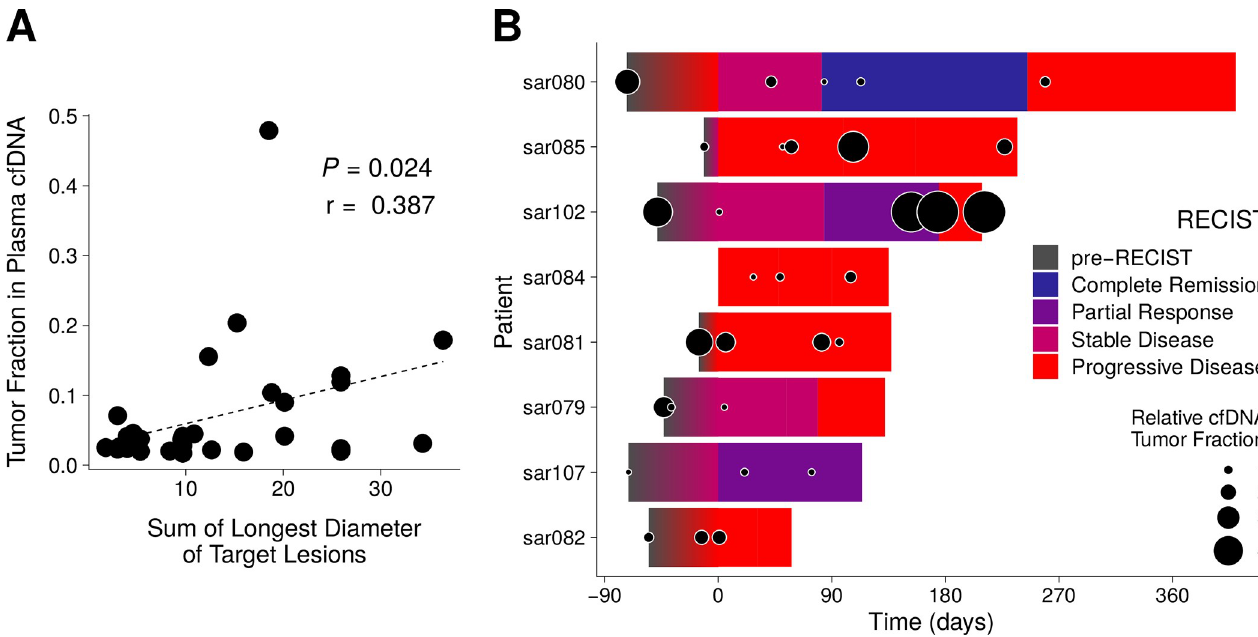
Fig 5. Tumor fraction in plasma correlates with imaging. (A) SLD of target lesions for all MPNST patients are plotted against each SLD’s temporally closest plasma tumor fraction value ( Methods ). Pearson correlation coefficient is significant at P = 0.024. (B) Timelines of RECIST classification for MPNST patients that underwent serial monitoring ( n = 8; S3 Fig ). Overlaid are cfDNA tumor fraction levels, normalized per patient to the lowest value detected on serial analysis, and then log 2 transformed ( Methods ). cfDNA, cell-free DNA; MPNST, malignant peripheral nerve sheath tumor; RECIST, response evaluation criteria in solid tumors, version 1.1; SLD, sum of longest tumor diameters.